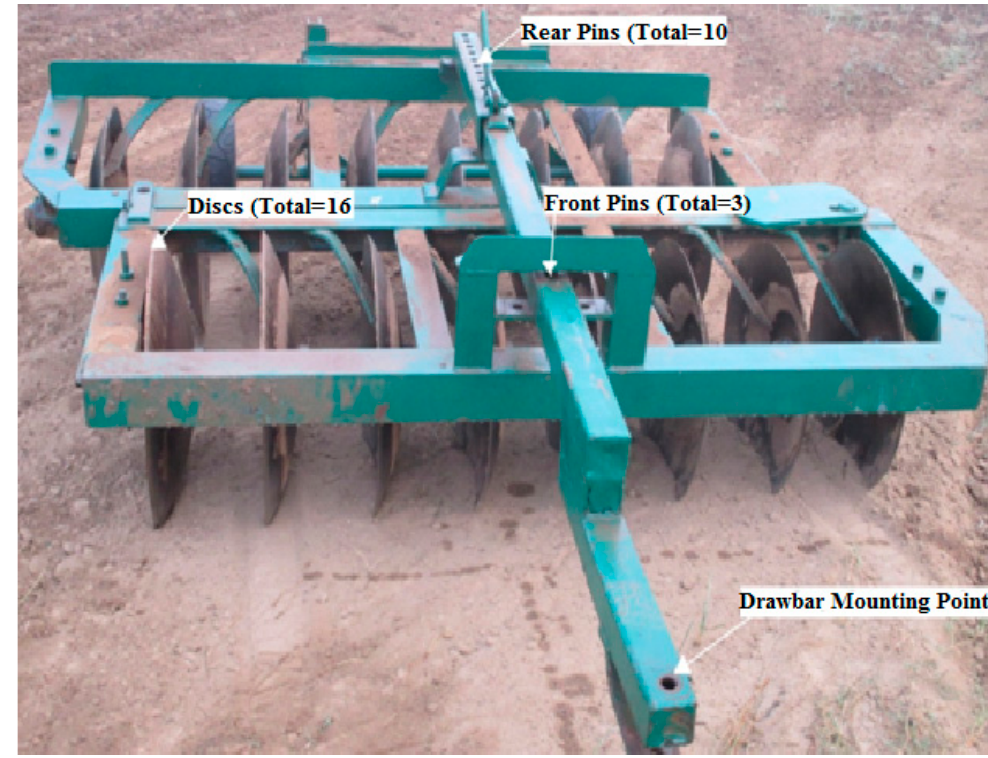
Figure 1. Representation of the disc harrow system.